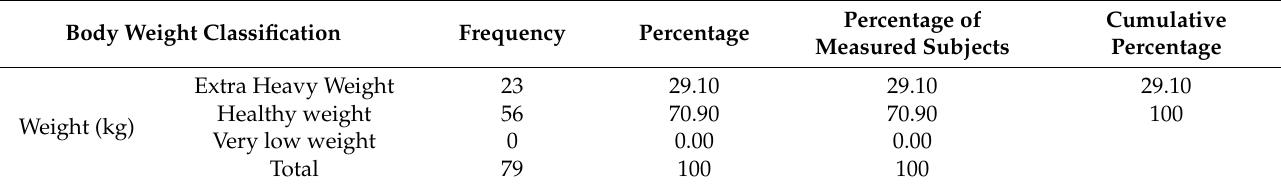
Table 3. Distribution of weight in the target group–initial testing.